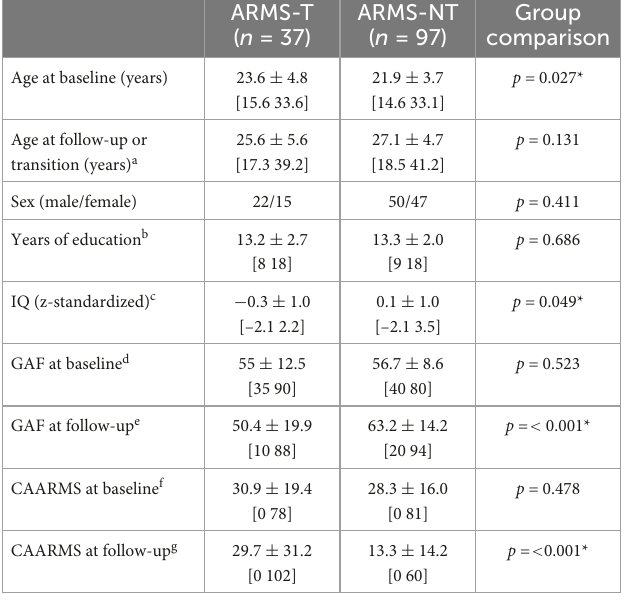
TABLE 3 Socio-demographic and clinical information of the At Risk Mental State (ARMS) sample with environmental data (with less than 20% of the environmental risk factors